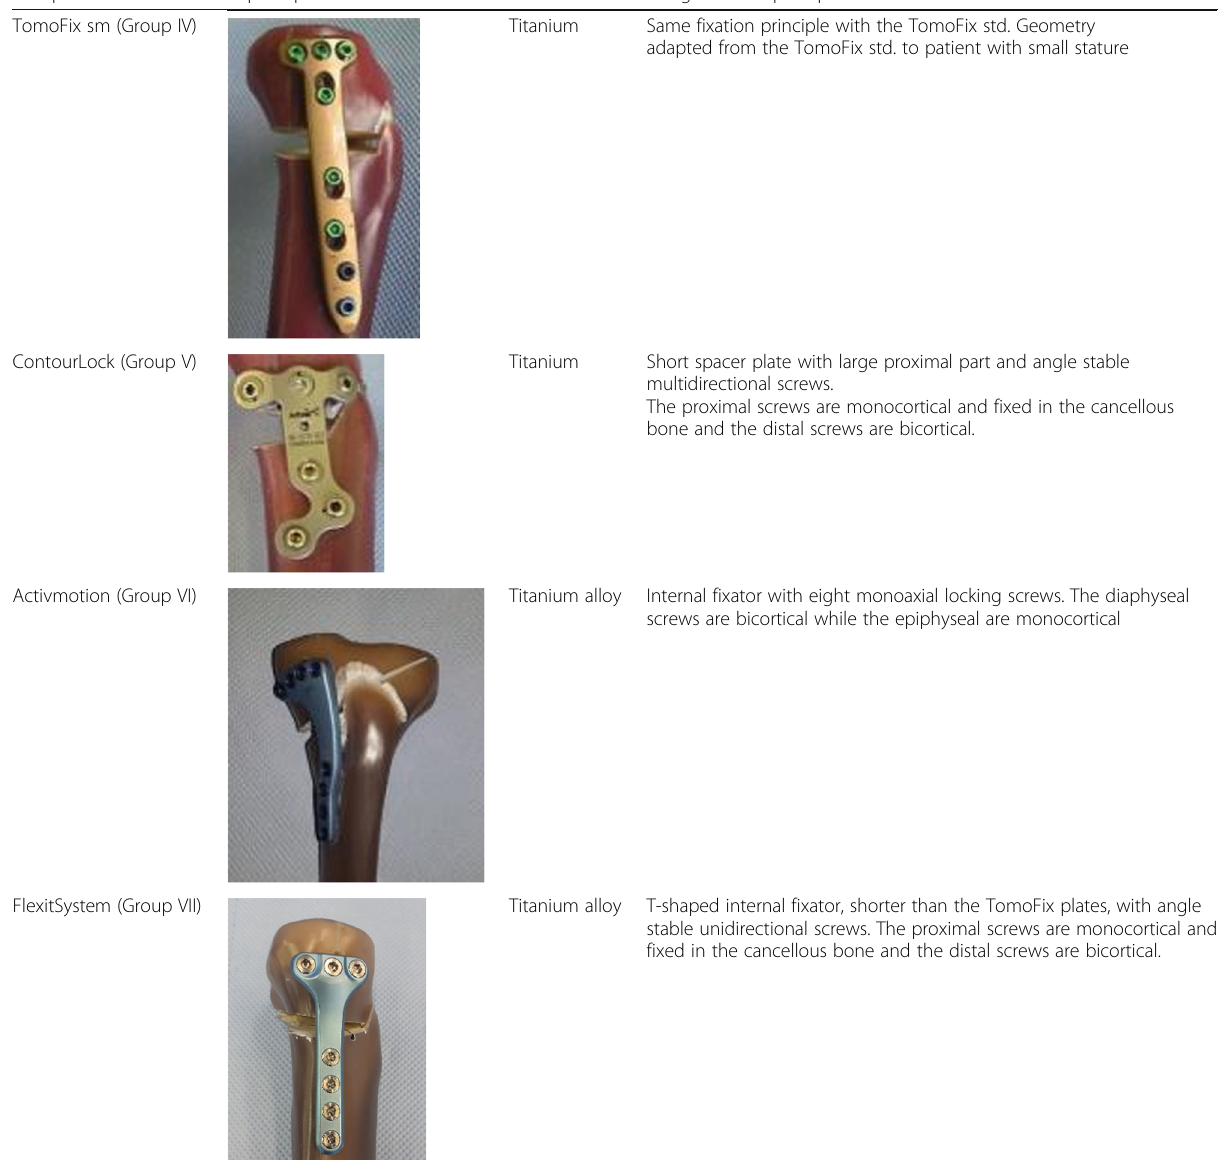
Table 2 Different HTO implants considered in the study (Groups IV to VII)